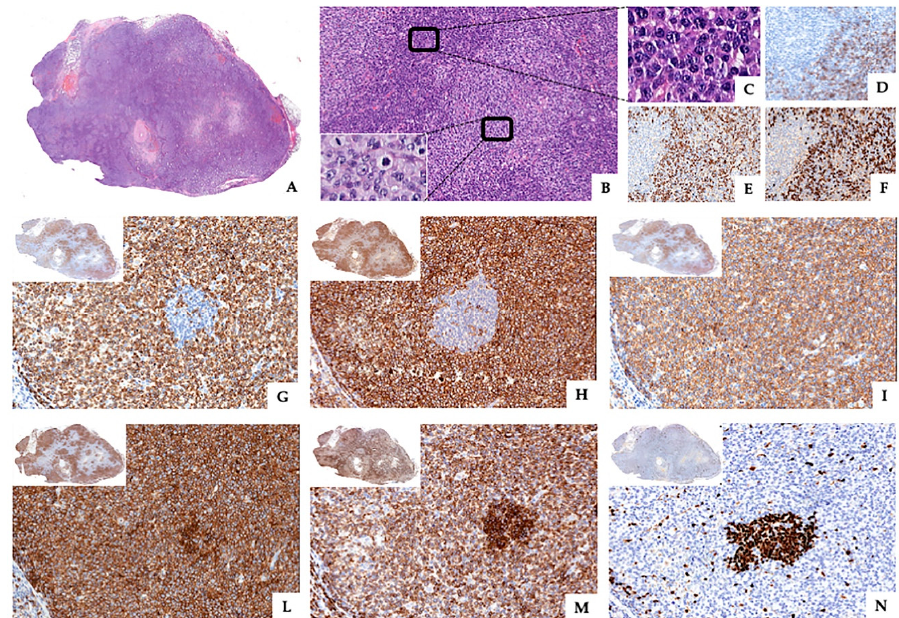
Figure 1. Lymph node architecture effaced by a pseudonodular infiltrate ( A ×7, hematoxylin and eosin, H&E) of medium/large-sized atypical lymphoid cells ( B ×100, lower inset ×400, H&E) clustered in large sheets separated by aggregates of polytypic plasma cells ( C ×400, H&E) expressing CD138 ( D ×400), kappa ( E ×400), and lambda ( F ×400) immunoglobulin light chains. Neoplastic cells stained for CD3 ( G ×200), CD4 ( H ×200), and CD5 ( I ×200), and B-cell-associated antigens CD20 ( L ×200) and CD79a ( M × 200). Conversely, PAX5 was not expressed by the tumor cells but only by the small reactive B lymphocytes ( N ×